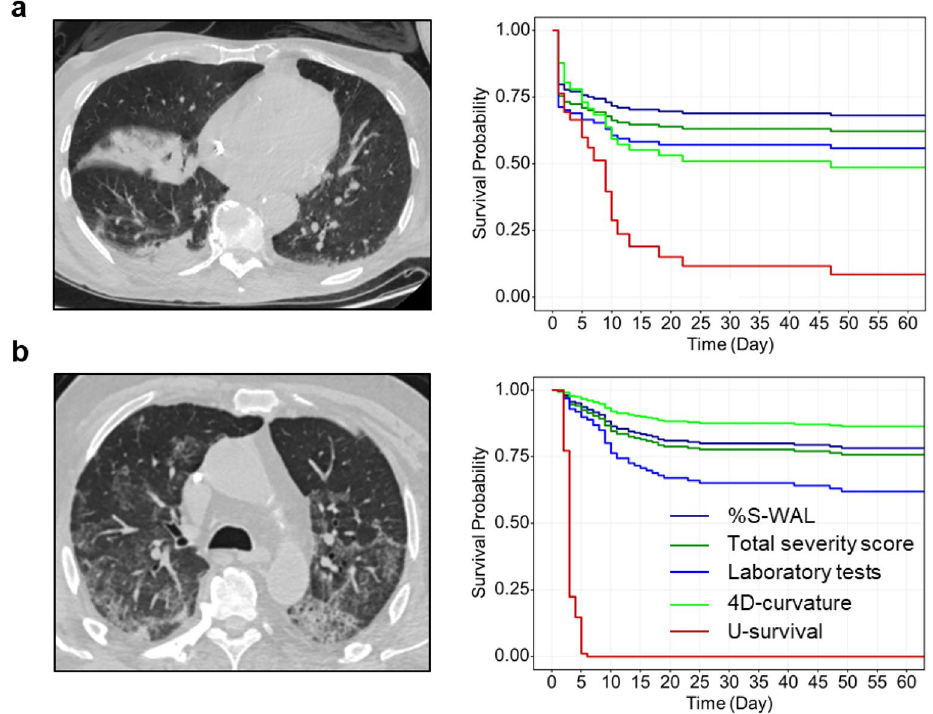
Figure 3. Representative chest CT images (left) and the corresponding per-patient survival curves (right) estimated by use of the predictors included in this study. ( a ) A 71-year-old male who was admitted to the ICU nine days after chest CT examination. The laboratory test results were dehydrogenase (LDH) 192 U/l, C-reactive protein (CRP) 126 mg/l, and lymphocytes 11.1%. The total severity score was 8, and the percentage of well-aerated lung parenchyma (%S-WAL) was 81.2%. The median survival times estimated by U-survival and 4DCurv were 8 and 47 days, respectively, whereas no median survival time was estimated by the other predictors. ( b ) A 64-year old male who expired three days after a chest CT examination. The laboratory test results were LDH 276 U/l, CRP 157 mg/l, and lymphocytes 4.6%. The total severity score was 12, and %S-WAL was 64.4%. The median survival time estimated by the U-survival was 3 days, whereas no median survival time was estimated by the other